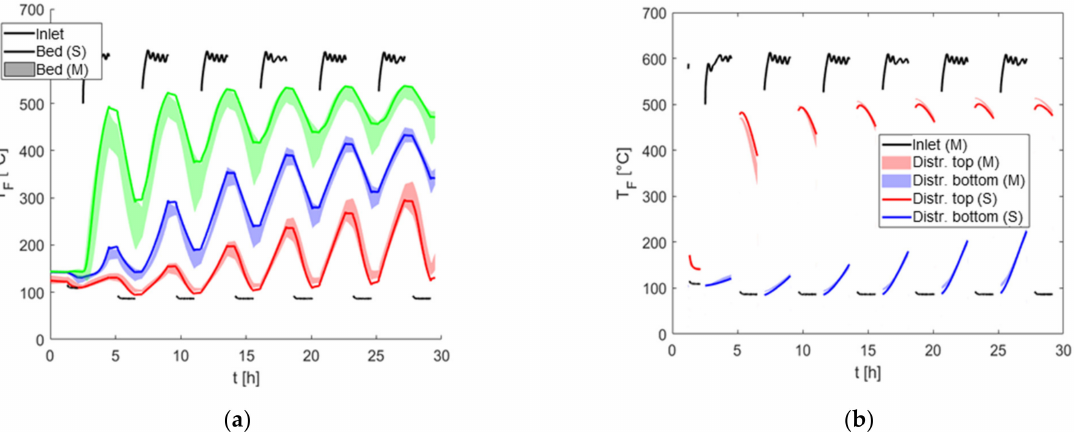
Figure 23. Test T3—Fluid temperature (TF), measurement (M), simulation (S): ( a ) temperature at bed height 0.3 m (red), 0.9 m (blue), 1.5 m (green); ( b ) temperature in the hot-side (top)/cold-side (bottom) manifold.